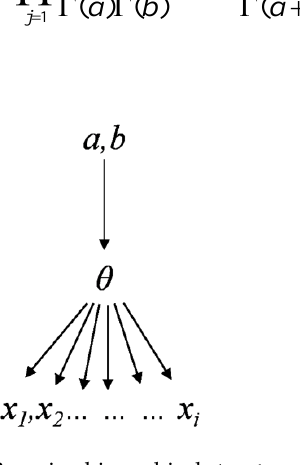
Figure 3. Bayesian hierarchical